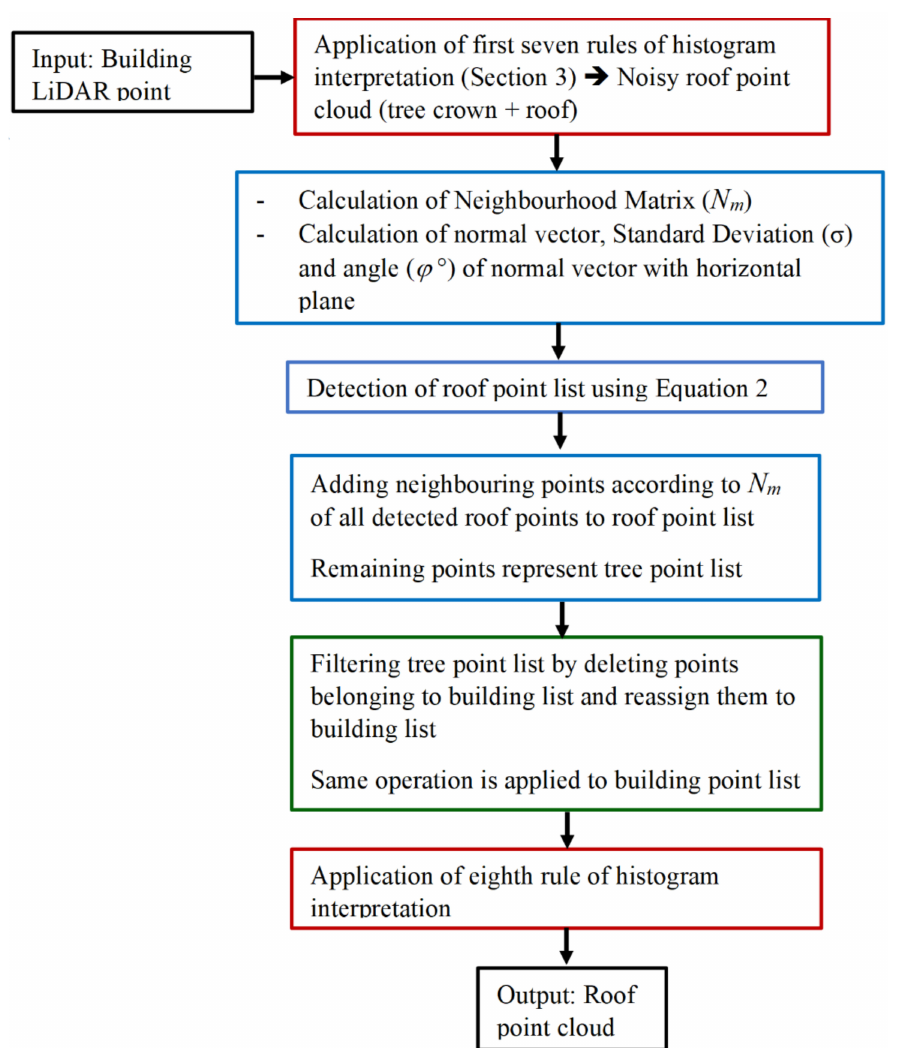
Figure 4. Workflow of the extended filtering algorithm where σ is the standard deviation of the fitted plane, ϕ ◦ is the angle of the normal vector with the horizontal plane, C cf is the change of curvature factor, and T h σ , T h ϕ and T hccf are their respective